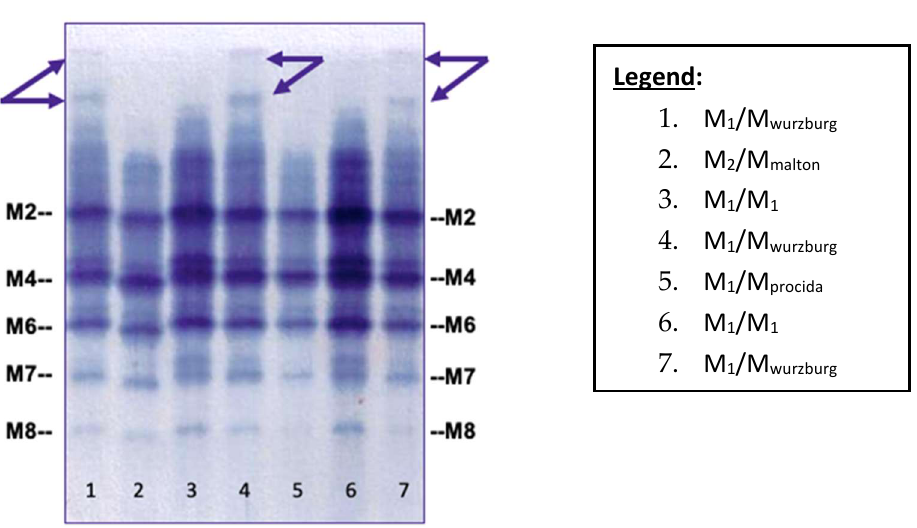
Figure 1. IEF pattern of M-like variants obtained by Sebia Hydrasys ® System on DBS samples. M2, M4, M6, M7, and M8 represent the different M isoforms [11,12]. (Arrows show the specific pattern of M wurzburg ).